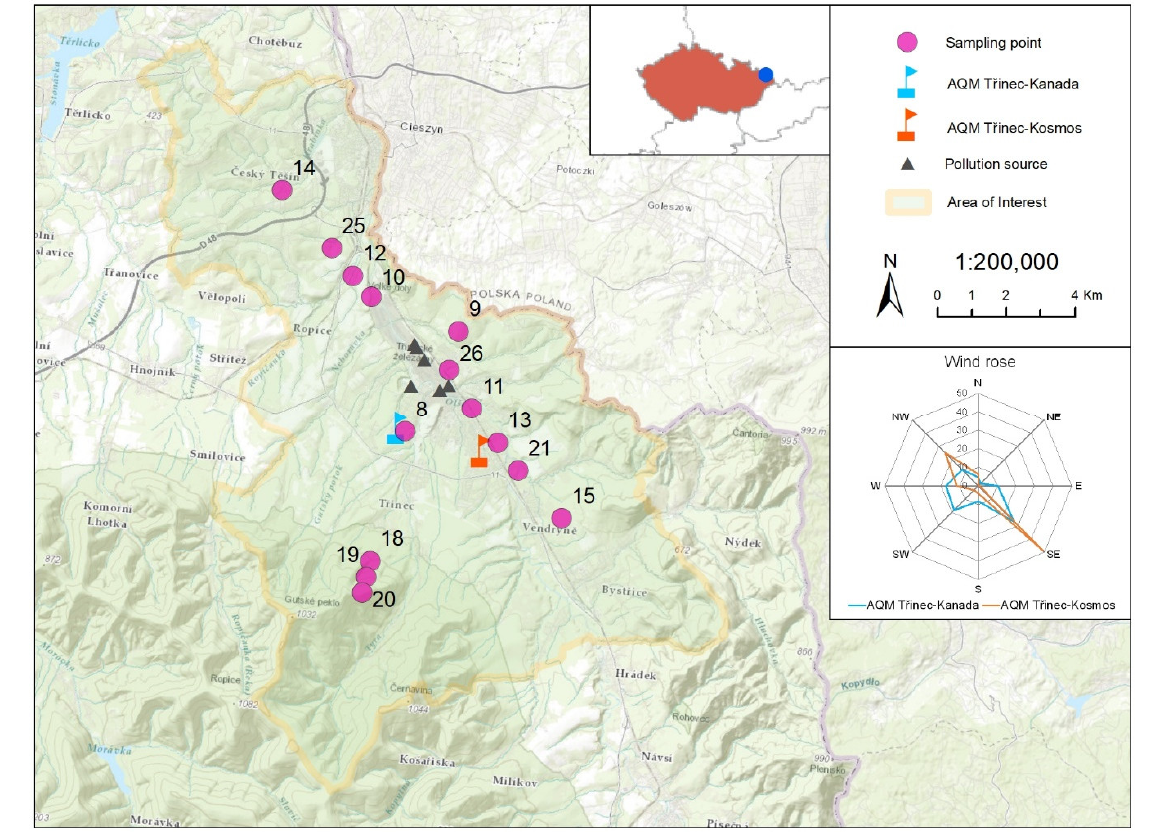
Figure 4. The sampling network and the wind rose.